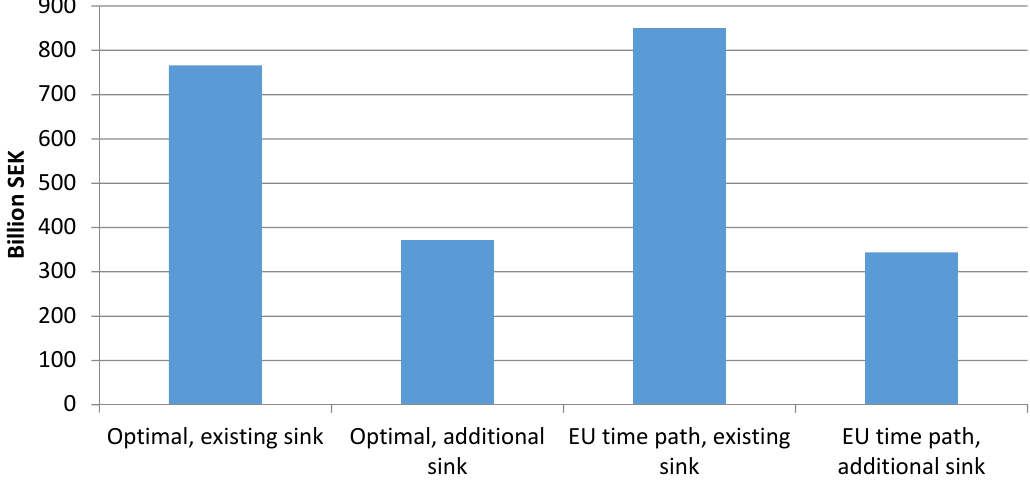
Figure 5. Value of forests as pollutant sinks for reaching the EU 2050 climate target and the BSAP nutrient targets in the Stockholm-Mälar region optimally or under the EU time path without